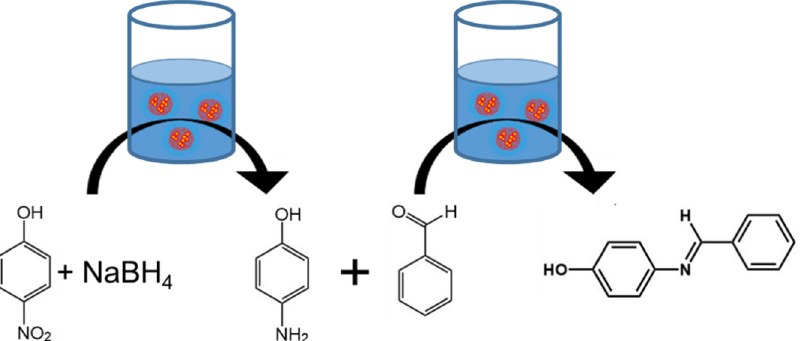
Figure 2. Schematic of the one-pot condensation of benzaldehyde with 4-nitrophenol. First, 4-nitrophenol and sodium borohydride were added to an aqueous dispersion of polymer nanoreactors to produce 4-aminophenol. After the first reaction, the pH was adjusted using formic acid and sodium hydroxide. Finally, addition of benzaldehyde facilitated the condensation of benzaldehyde with 4-aminophenol to produce the desired 4-benzylideneaminophenol product which spontaneously phase separated from the nanoreactor dispersion.